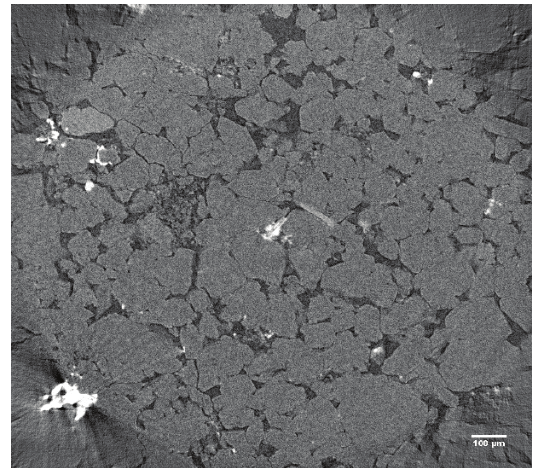
Fig. 1. 2D tomographic image of Carboniferous sandstone, nanotomograph at FPACS AGH in Cracow; light grey area – grains, dark grey – pore space